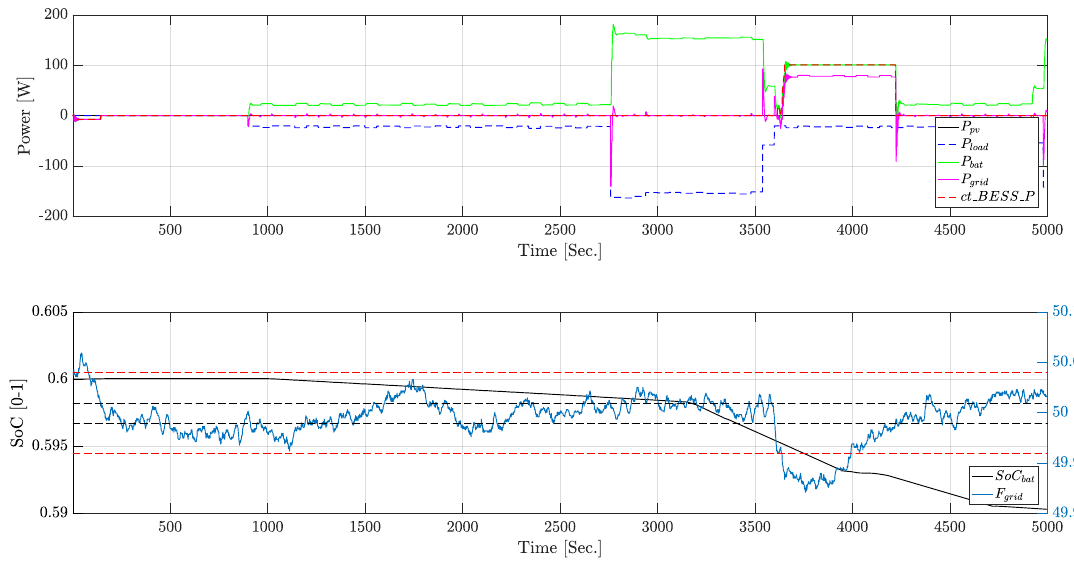
Figure 14. Offline simulation of the CEMS use case to achieve FW and